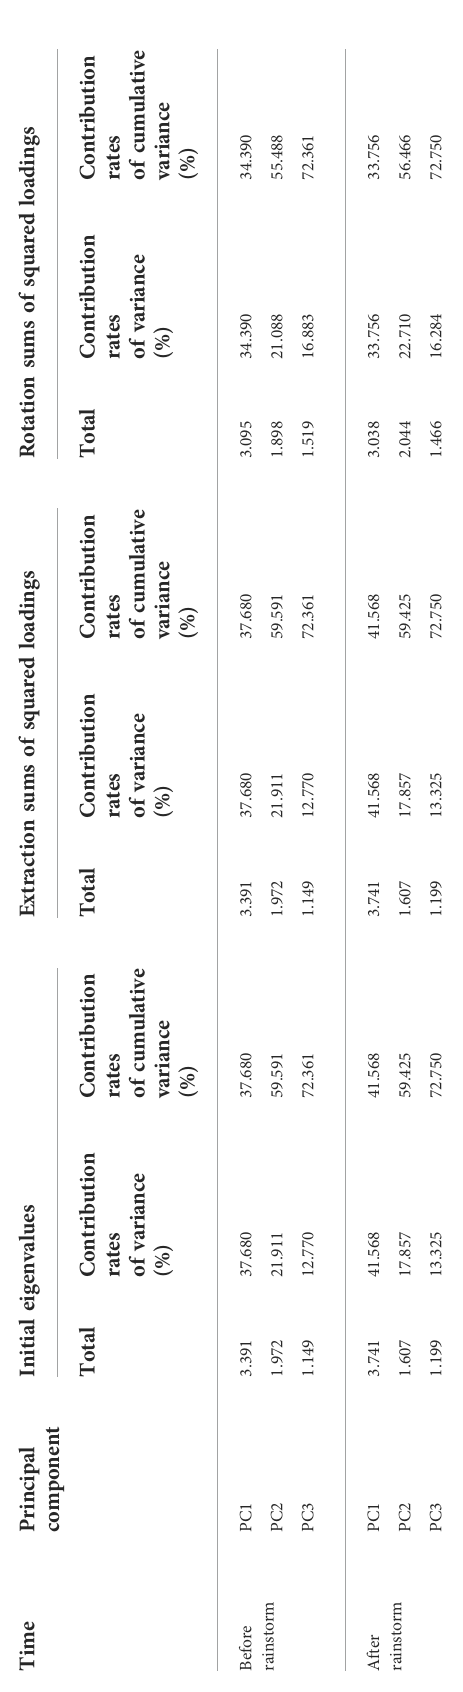
variance was 12.770%. The main load water quality indicator was WT. After the rainstorm (Figure 9B), the eigenvalue of the fi rst principal component (PC1) extracted was 3.741, and the contribution rate of variance was 41.568%. The main load water quality indicators were turbidity, COD Mn , NH 3 − N, TP and TN. The eigenvalue of the second principal component (PC2) was 1.607, and the contribution rate of variance was 17.857%. The main load water quality indicators were WT, pH and DO. The eigenvalue of the third principal component (PC3) was 1.199, and the contribution rate of variance was 13.325%. The main load water quality indicator was EC. The linear fi tting results of the predictive values and measured values of water pollutants before and after the rainstorm are shown in Figure 10. The results indicated that the R 2 values of the linear fi tting were all above 0.50 between the predicted values and measured values of DO, TP and TN before and after the rainstorm. The R 2 values of the linear fi tting was 0.1856 between the predicted values and measured values of COD Mn before the rainstorm but was 0.7613 after the rainstorm. The R 2 values of the linear fi tting was approximately 0.47 between the predicted values and measured values of NH 3 − N before and after the rainstorm. Overall, the APCS- MLR was basically reliable, and the calculation results were more reliable. In Figure 11, the absolute contribution rate of DO from the PC2 before the rainstorm was 56.29%, and the absolute contribution rates of the PC2 and unidenti fi ed pollution sources were 50.77 and 47.35% after the rainstorm, respectively. The impact of the PC2 on DO decreased after the rainstorm, while the impact of unidenti fi ed pollution sources on DO increased. The absolute contribution rates of COD Mn form the PC1 and unidenti fi ed pollution sources were 33.86 and 38.04% before the rainstorm, respectively. The absolute contribution rate of unidenti fi ed pollution sources was 43.12% after the rainstorm, and the impact of the PC3 and unidenti fi ed pollution sources on COD Mn increased. The absolute contribution rates of NH 3 − N form the PC2 and unidenti fi ed pollution sources were 39.09 and 37.01% before the rainstorm, respectively, while the absolute contribution rates of NH 3 − N increased after the rainstorm, which were 45.09 and 51.62%, respectively. The absolute contribution rates of TP form the PC1 and the PC2 were 41.11 and 45.59% before the rainstorm, respectively. The absolute contribution rates of TP from the PC2 and unidenti fi ed pollution sources were 45.43 and 47.51%, respectively, after the rainstorm, and the impact of the unidenti fi ed pollution sources on TP increased. The absolute contribution rates of TN from the PC1 and the PC2 were 31.05 and 35.79% before the rainstorm, respectively. The absolute contribution rates of TN from the PC2 and unidenti fi ed pollution sources increased after the rainstorm, which were 60.26 and 34.77%, respectively. T